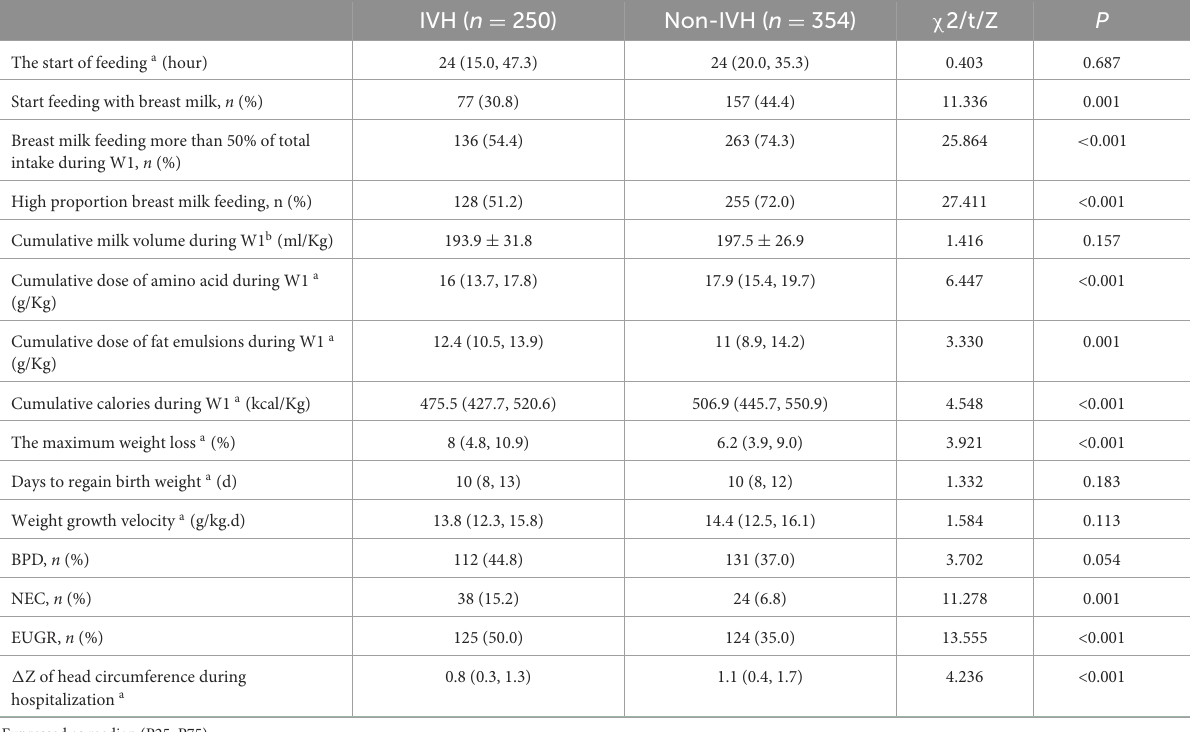
TABLE 3 Comparison of nutritional status, growth, and complications of preterm infants between the two groups.